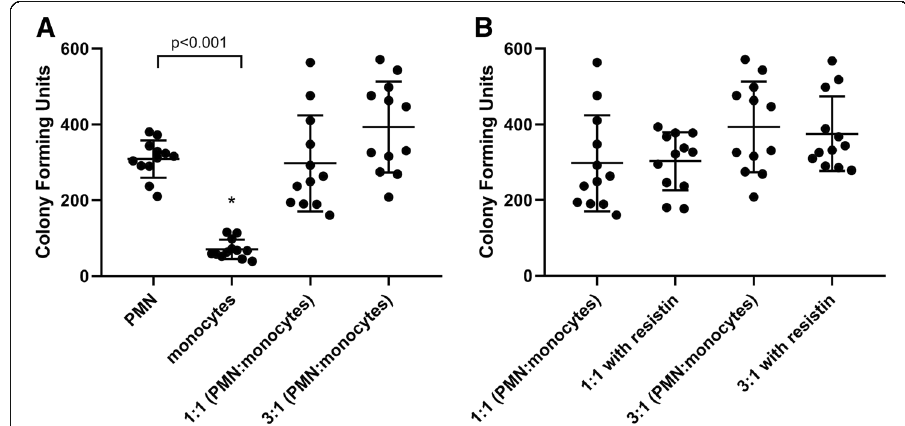
Fig. 4 Effect of co-incubation of PMN (neutrophils) and monocytes on bacterial killing of S. aureus with different ratios of PMN to monocytes in the a absence of resistin and b presence of resistin. Direct co-incubation was achieved by mixing PMN and monocytes in 1:1 ratio and 3:1 ratio (total cell counts kept the same in each condition). Co-incubation with increasing proportions of monocytes did not improve killing of S. aureus , neither did it cause any change in bacterial killing in the presence of resistin. n = 12 for all experiments. Asterisk denotes statistical significance ( P <